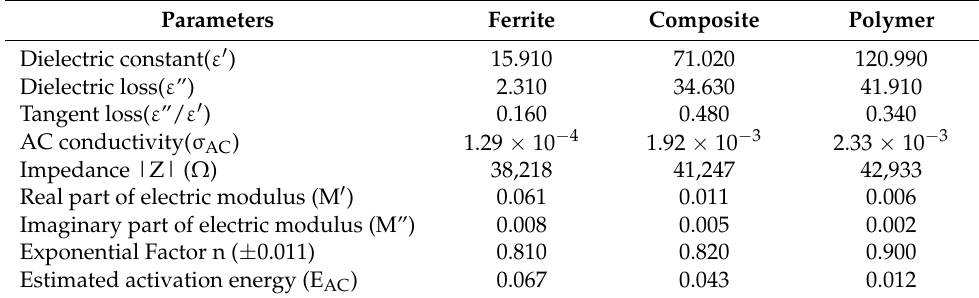
Table 1. The dielectric values of ferrite, composite and polymer. Parameters Ferrite Composite Polymer Dielectric constant( ε (cid:48) )